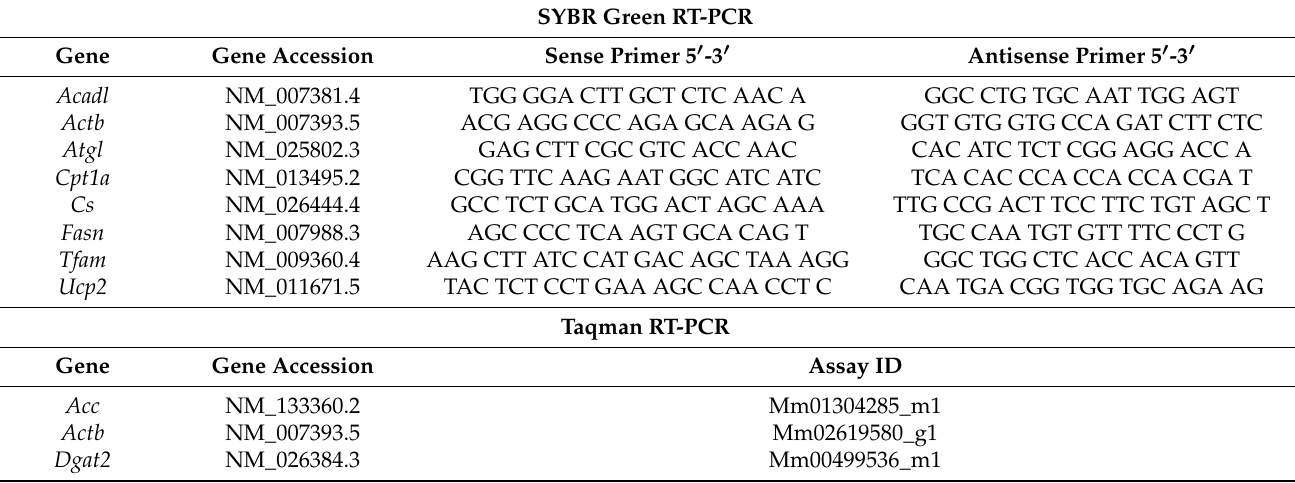
Table 1. Primer sequences, gene accession and assay ID for quantitative Real-Time PCR amplification. SYBR Green